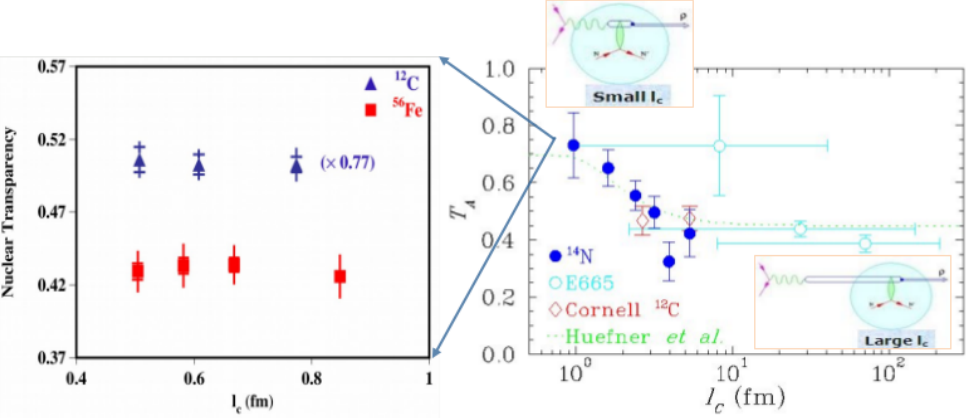
Figure 2. The nuclear transparency as a function of the coherence length l c , illustrating the CL effect, observed by the HERMES Collaboration ( right ) and the CLAS experiment result ( left) , where the carbon data have been scaled by a factor of 0.77 to match the iron data scale [40]. The dashed curve in the right diagram is a model calculation by Hufner et al. [41] while the arrows indicate the l c range covered by the CLAS6 measurement compared to HERMES. See text for